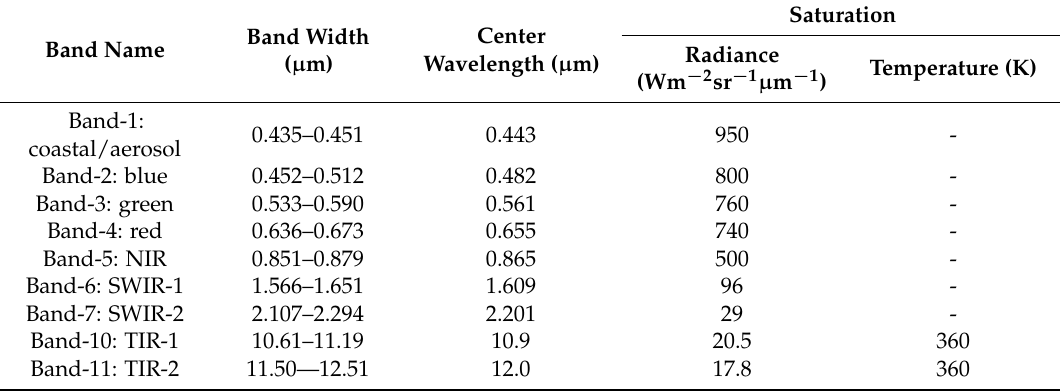
Table A1. Spectral properties of Landsat-8 OLI and TIRS [55,60,61]. The radiance and temperature values are at sensor at the Top of Atmosphere (TOA). The TOA temperature is only measured in TIR